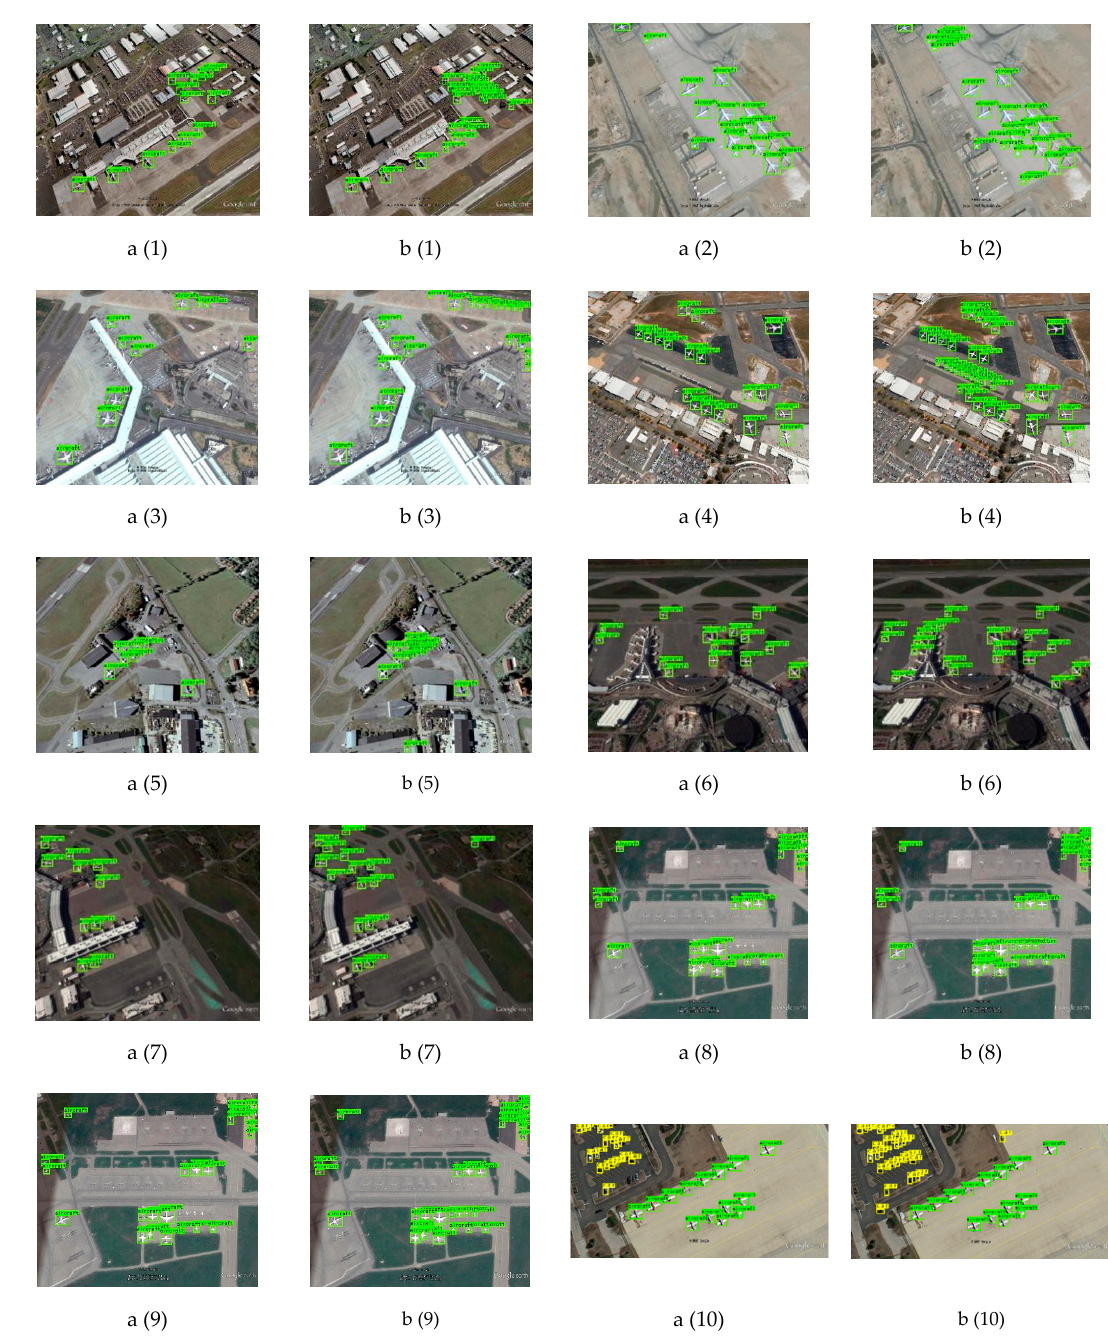
Figure 17. The comparison results of YOLO-V3 and our proposed EF-YOLO: a (1)–a (10) are the detection results of YOLO-V3; b (1)–b (10) are the corresponding detection results of FE-YOLO.